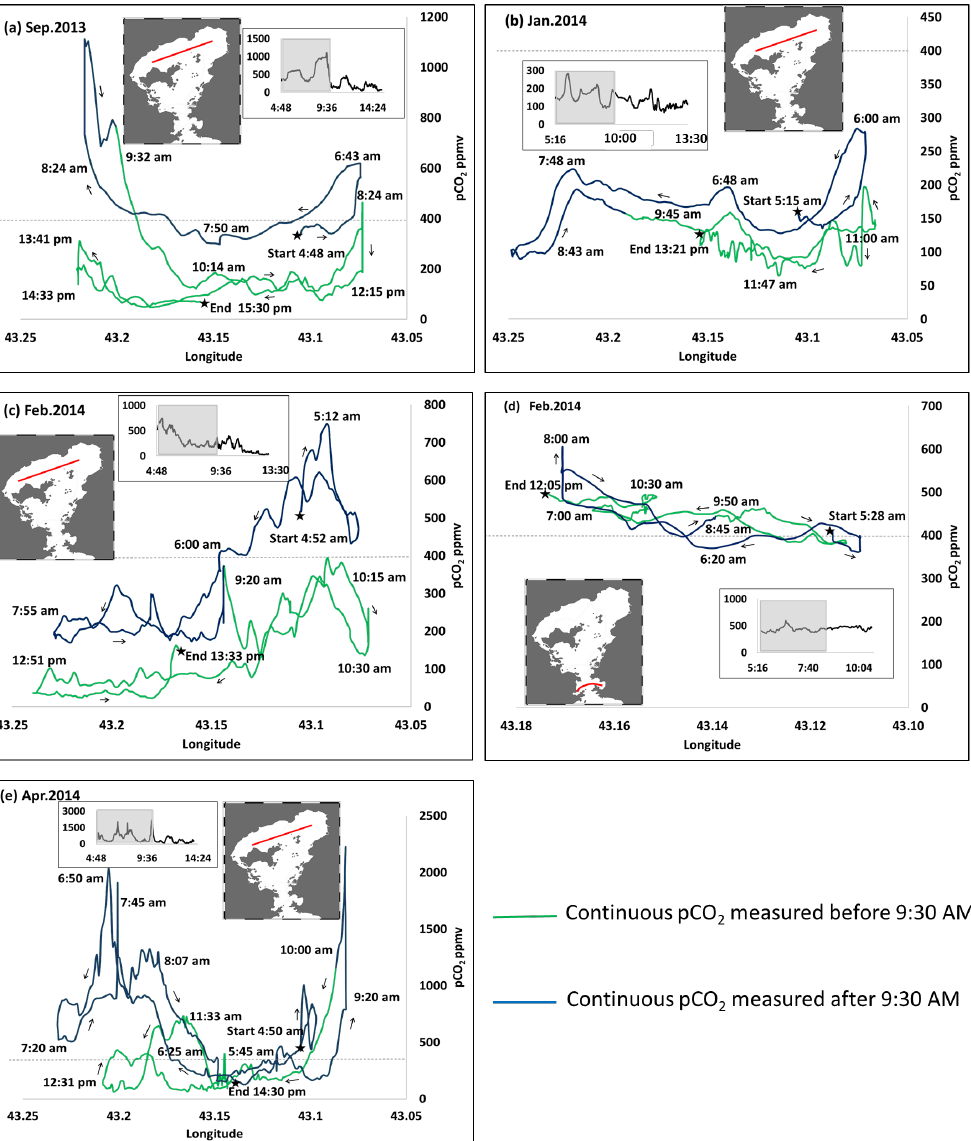
Figure 5. Diurnal variations in p CO 2 concentrations. The ship back-and-forth tracks are indicated as red lines in small maps. Arrows show the boat direction, and sampling times are indicated along each track. Blue parts of the tracks are considered as night-time ( < 09:30) and green parts as daytime ( > 09:30). Inserted small graphs also show the water p CO 2 evolution vs. time, and the shaded area represents the sampling before 09:30 (night-time). The grey lines indicate the atmospheric p CO 2 (400ppmv). Note the different p CO 2 scales for each